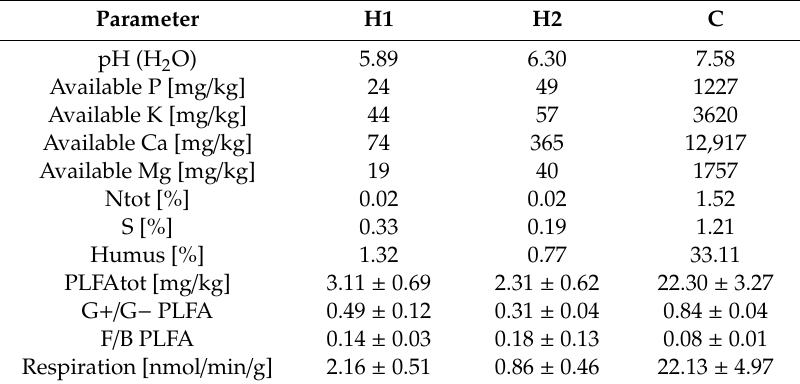
Table 1. Chemical and microbial parameters determined in soils used in experiment.